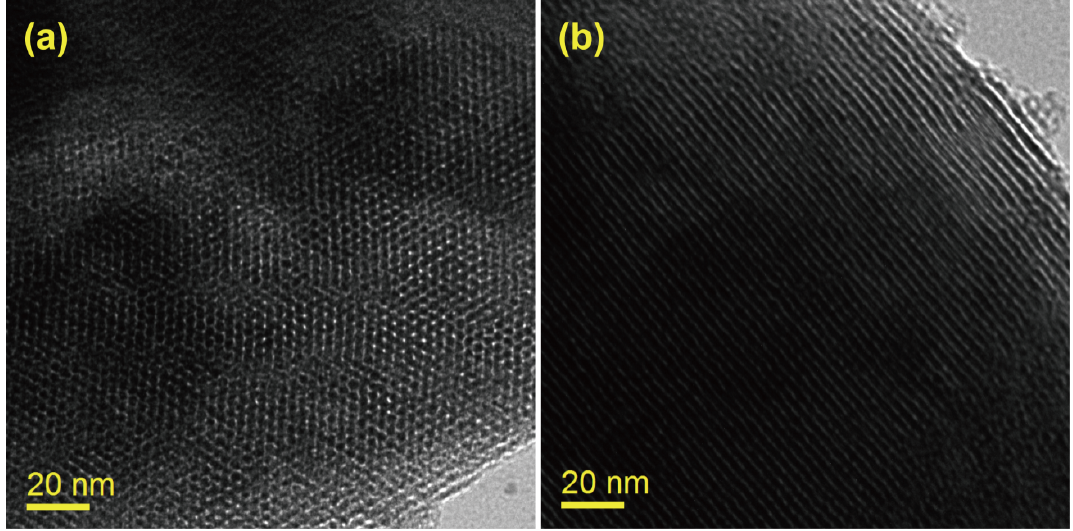
Figure 3. Transmission electron microscopy (TEM) images of Al–MCM–41: ( a ) the direction perpendicular to the pore axis; ( b ) the direction of the pore axis.